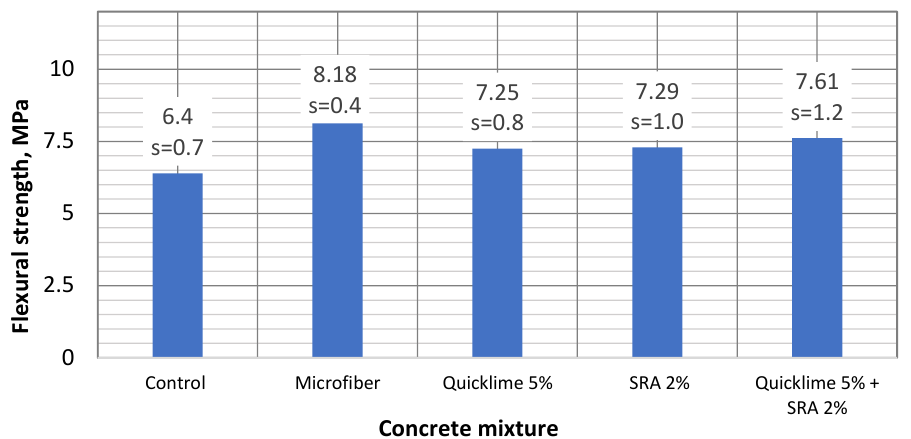
Figure 5. The flexural strength results of various concrete compositions.